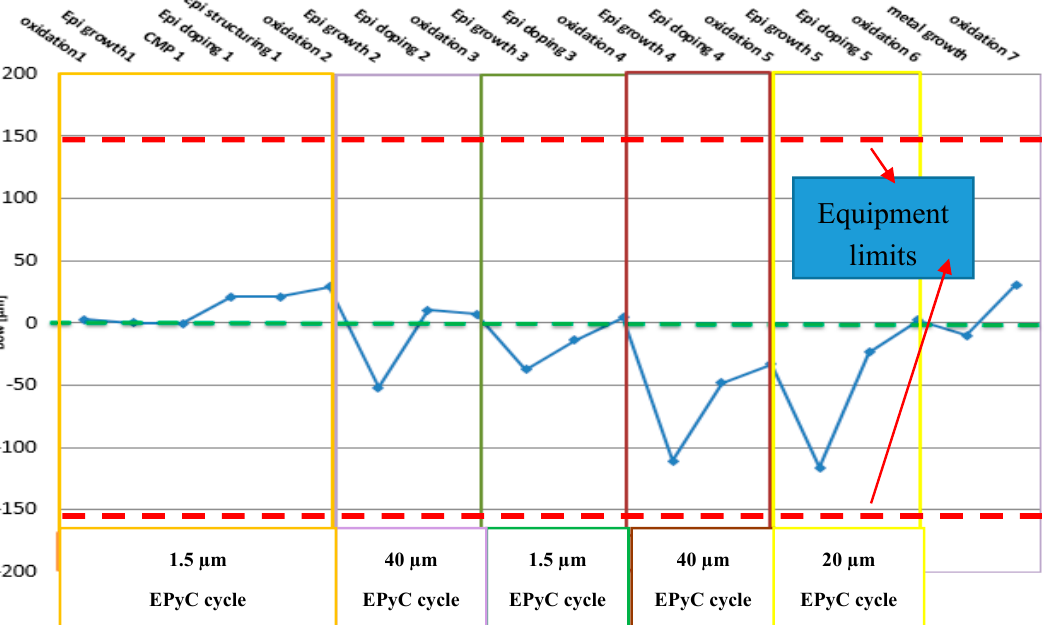
Figure 3. The propagation of the wafer-bow during the wafer-process of the comb structure. Each single EPyC and the full process with 5 EPyC cycles was managed to run nearly